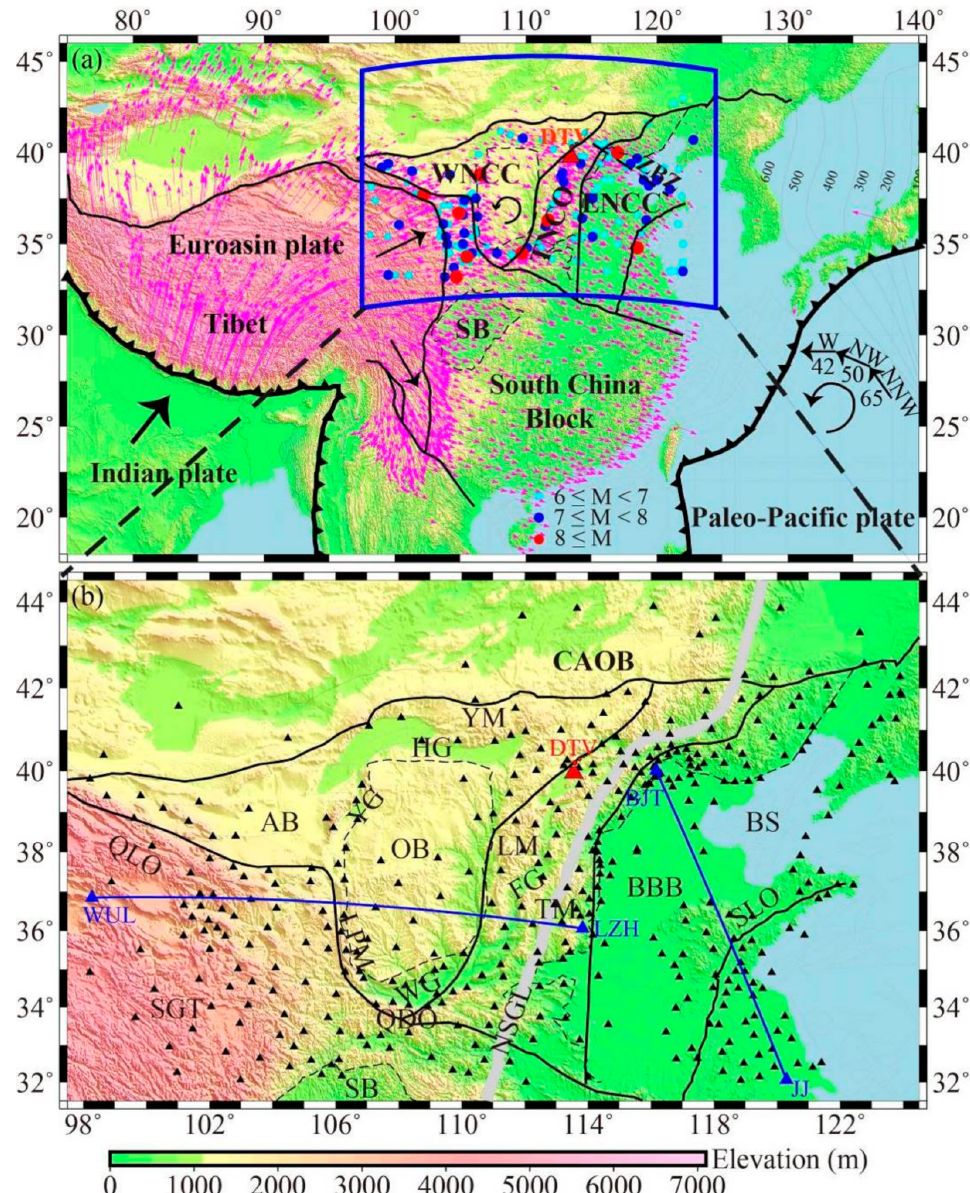
Figure 1. Tectonic setting and seismic station coverage in this study. ( a ) Schematic diagram showing the collision between the Indian and Eurasian plates, and the subduction of Paleo-Pacific plate (modified after Clark et al. [5] and Zhu et al. [6]). The thick blue rectangle indicates the study area. The bold black lines mark the boundaries of the major tectonic units. The cyan, blue and red circles are the large historic earthquakes (M ≥ 6, [7,8]). The black arrows represent the movements of the different blocks or plates. The magenta arrows show the GPS velocity [9]. WNCC: western North China Craton, TNCO: Trans-North China orogen, ENCC: eastern North China Craton, ZBZ: Zhangbo fault zone, SB: Sichuan basin. ( b ) Topographic map with the seismic stations used in this study. The thick gray line denotes the North–South Gravity Line (NSGL). The black triangles show the location of the stations. The red triangle is the Datong volcano (DTV). The blue lines indicate the paths of station pair WUL–LZH and BJT–JJ. SGT: Songpan–Ganzi terrane, QLO: Qilian orogen, AB: Alax